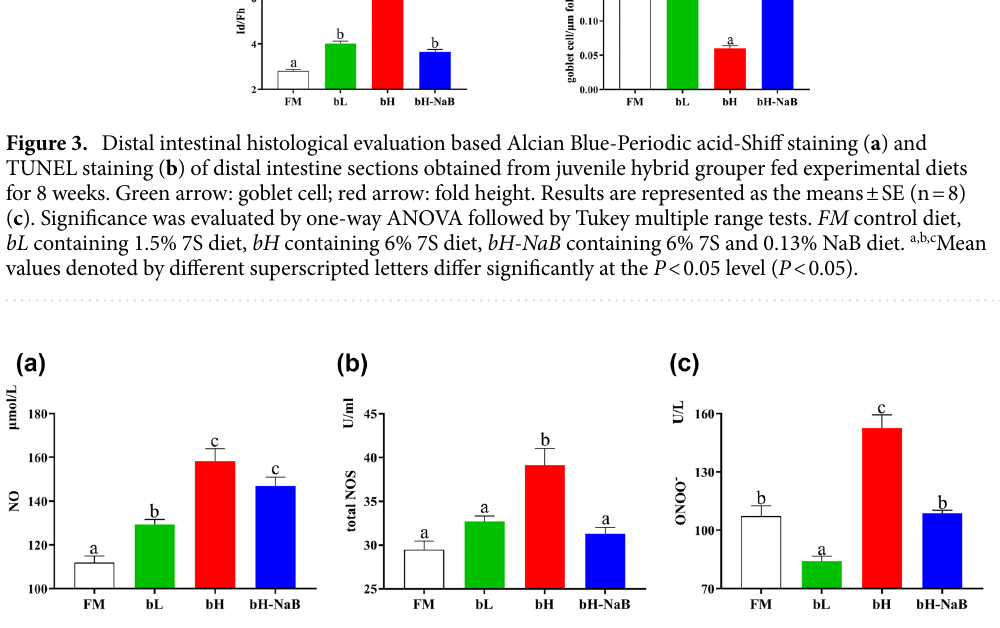
Figure 4. Distal intestinal damage indicators of juvenile hybrid grouper fed the experimental diets for 8 weeks ( P < 0.05). ( a ) NO, nitric oxide; ( b ) total NOS, total nitric oxide synthase; ( c ) ONOO − , peroxynitrite. a,b,c Mean values denoted by different superscripted letters differ significantly at the P < 0.05